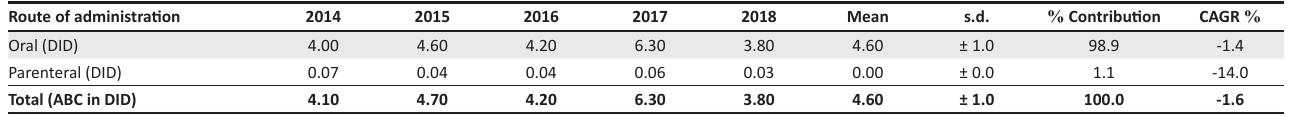
TABLE 1: Total antibiotic consumption and by route of administration. Route of administration